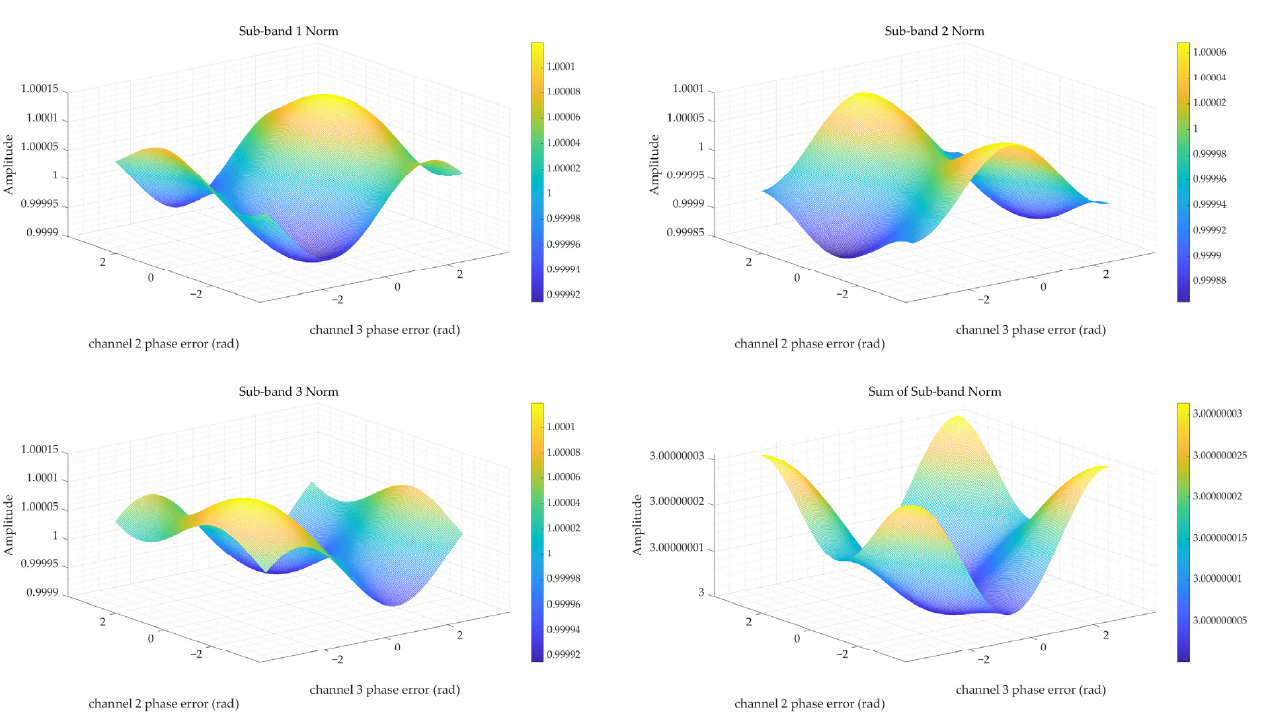
Figure 5. The norm of the row’s sum of the weight matrix and the sum of the norm. According to the subadditivity of linear normed space, the SBN satisfies the follow- ing